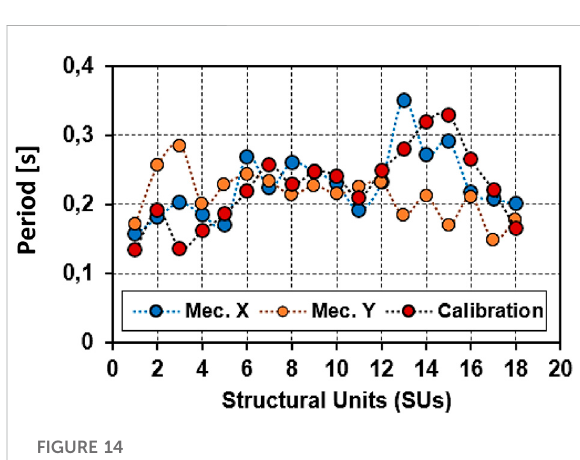
FIGURE 14 Comparison between theoretical and numerical approaches for predicting the main vibration period of aggregate